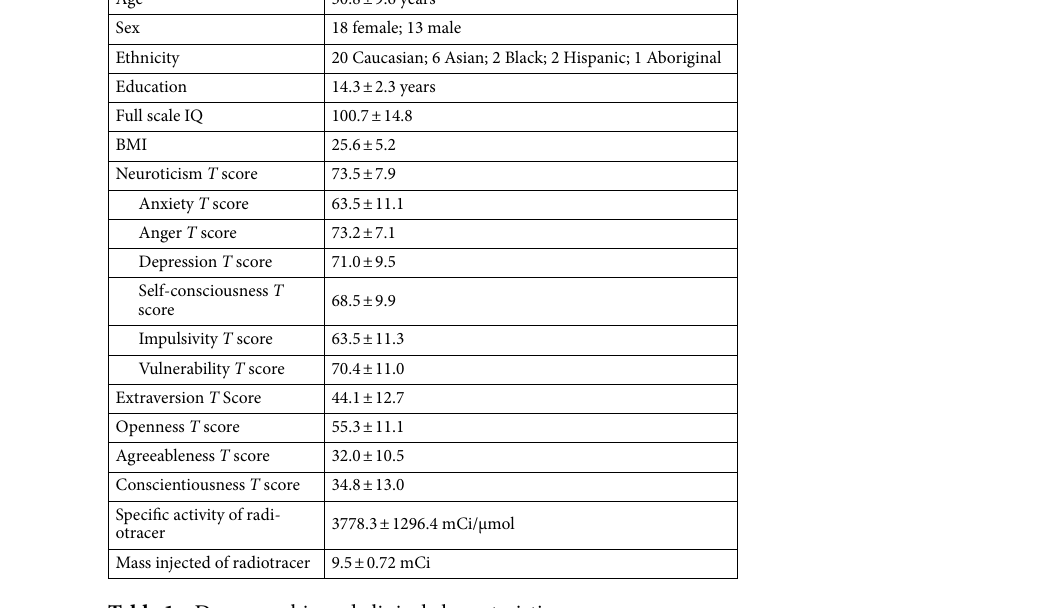
Table 1. Demographic and clinical